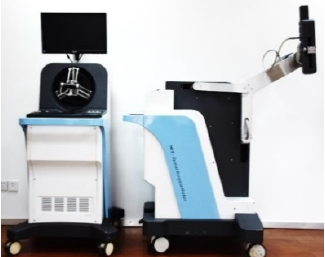
Figure 2. 5-DOF hybrid manipulator.